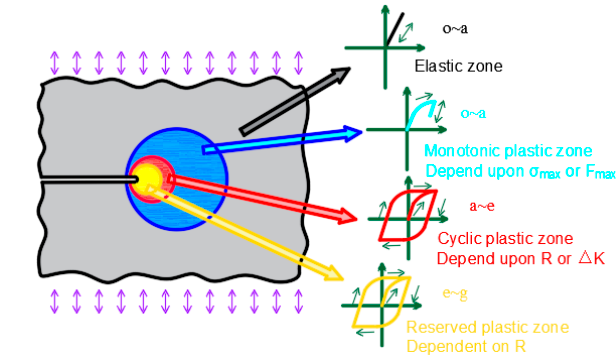
Figure 13. Diagram of various plastic zones of the crack tip